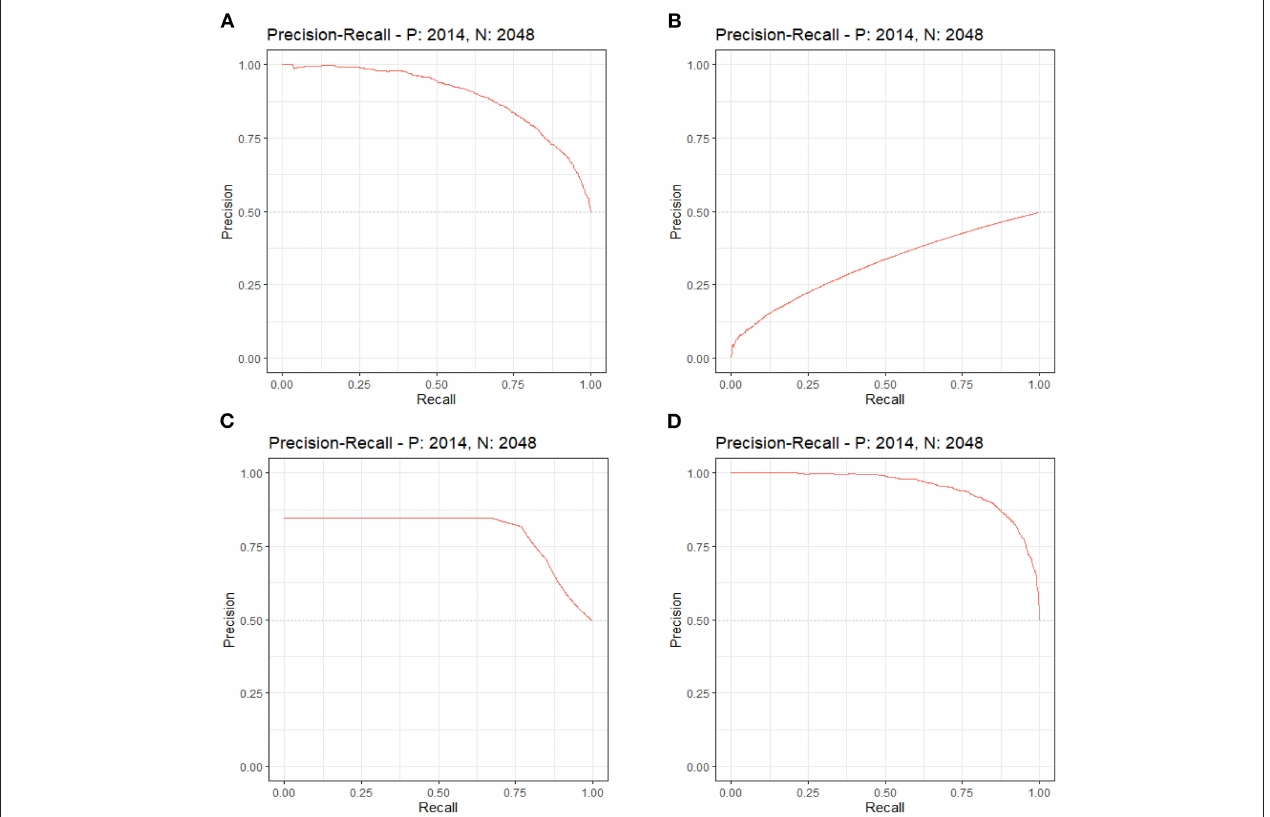
FIGURE 3 | Each machine learning model was evaluated by the precision-recall curve, which displays the trade-off between recall ( x -axis) and precision ( y -axis). The bigger area under the curve, the greater predictive capability of the model. (A) Logistic regression. (B) Support vector machine (SVM). (C) Decision tree classification. (D) Random forest (RF).